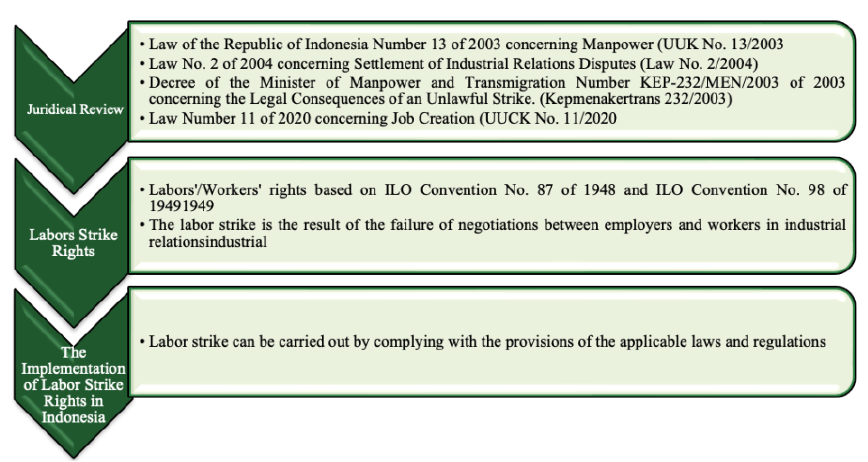
Figure 1: Implementation of the Labors Strike Rights in